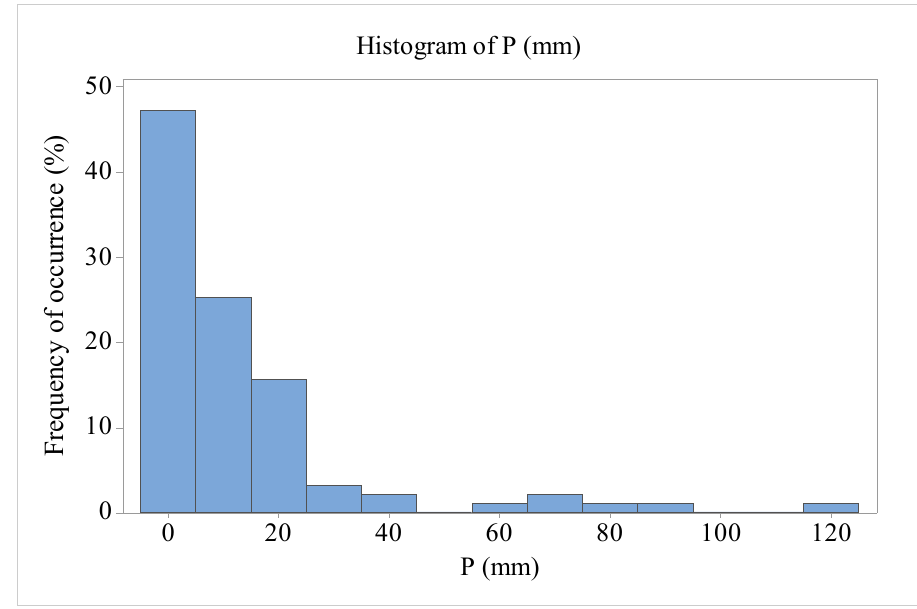
Figure 4. Frequency of occurrence of the monitored rain events.